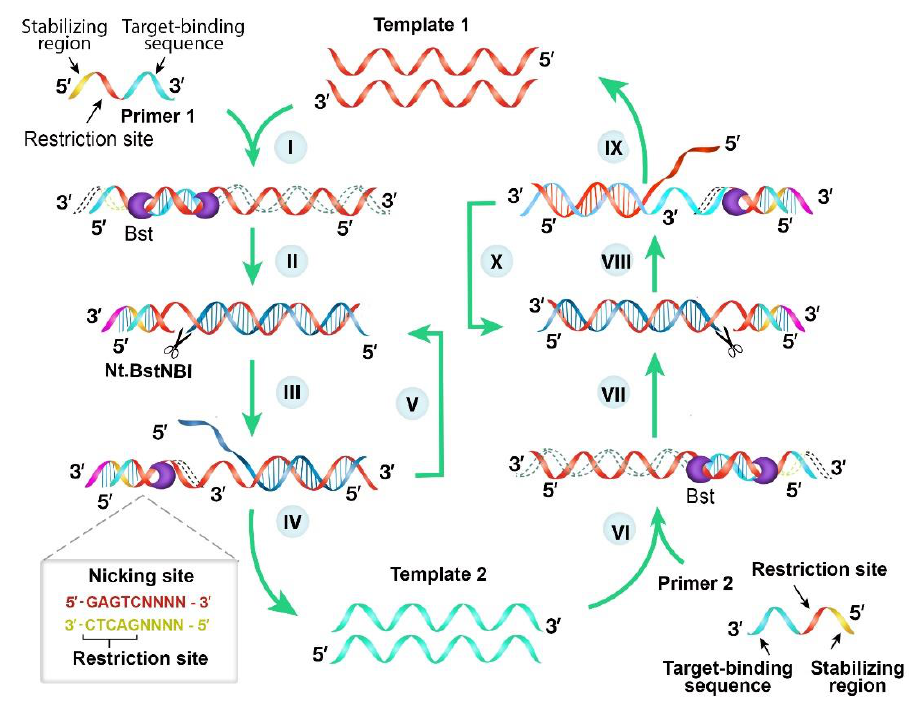
Figure 6. Schematic representation of nicking enzyme-assisted reaction. Unlike PCR primers, NEAR primers are uniquely designed for a successful reaction. Each primer has three regions: restriction site ( 5′ -GAGTCNNNN- 3‘, for example, Nt. BstNBI), stabilizing region and a target-binding region that is complementary to the target nucleic acid strand. First, the forward primer (primer 1) anneals with template 1 at the target-binding region and extended from its 3′ end by DNA polymerase. This results in the formation of an intermediate strand, complementary to template 1 (step I). At the same time, the nicking endonuclease recognizes the asymmetric restriction site ( 5‘ -GAGTC- 3′ ) cleaves the strand with four base pairs after the recognized sequence introduces a new nick site (step II). At the nick site, DNA polymerase initiates another extension and displace the intermediate strand generated in step I (step III and IV). This displaced strand (template 2) carries the target-binding sequence complementary to reverse primer (primer 2), and DNA polymerase extends from the 3′ end of this primer (step VI). Again, nicking endonuclease recognizes and cleaves the restriction site, and the polymerase enzyme extends and displaces the initial template strand (template 1) from the nick site, which is recovered (step VII and IX) for another cycle, starting from step I. The target template is exponentially amplified by repeating this cycle of events [53].